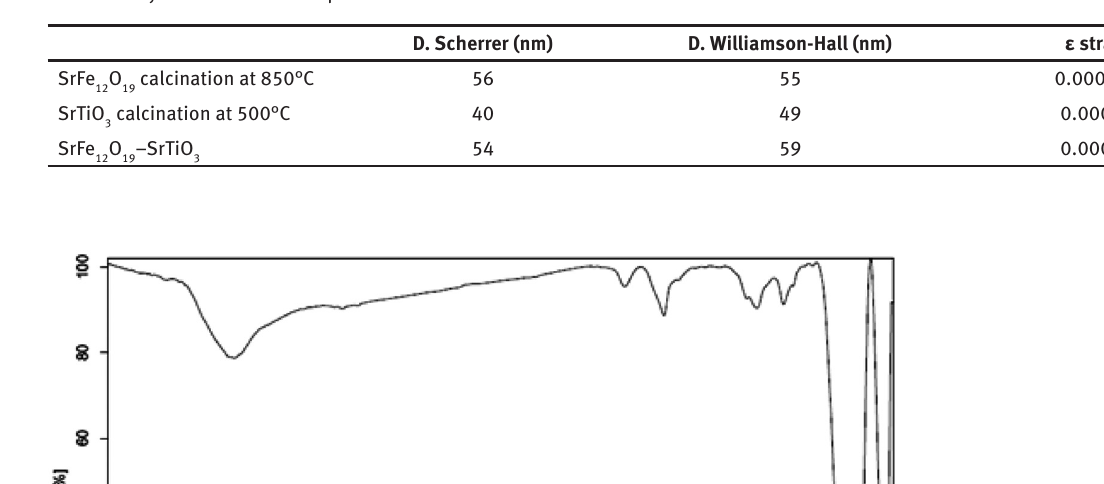
O –SrTiO nanocomposite. 12 19 3